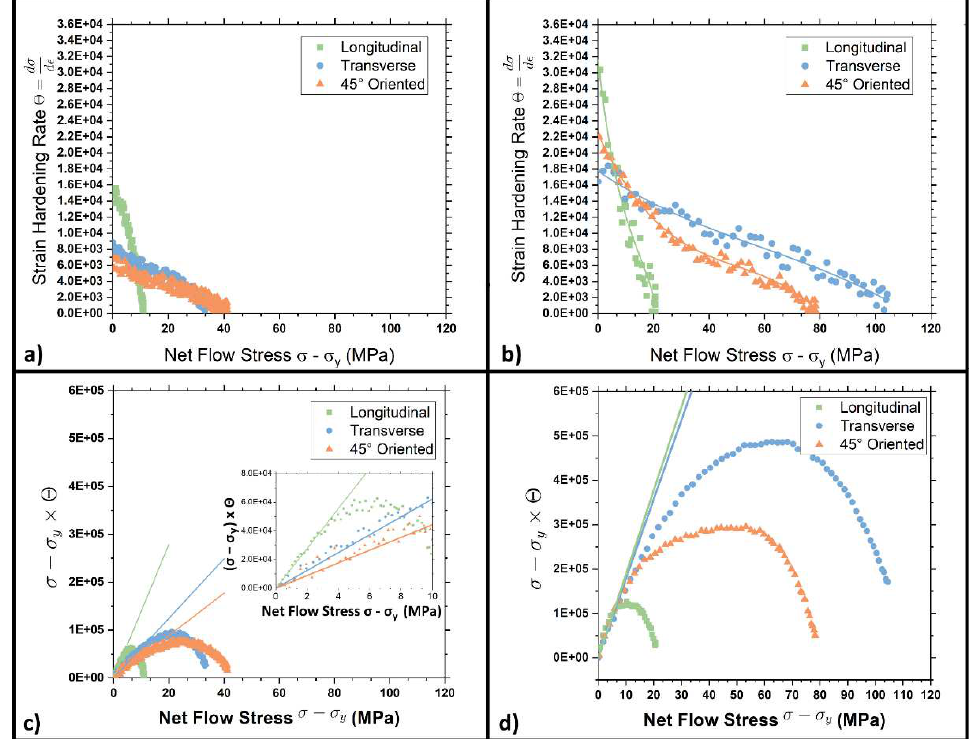
Figure 15. Strain hardening rate and net flow stress plots for samples with ( a ) 20 and ( b ) 50% strain hardening level; and (σ−Y)Θ versus net flow stress (σ−Y) plots for DP steel with ( c ) 20 and ( d ) 50% strain hardening level.